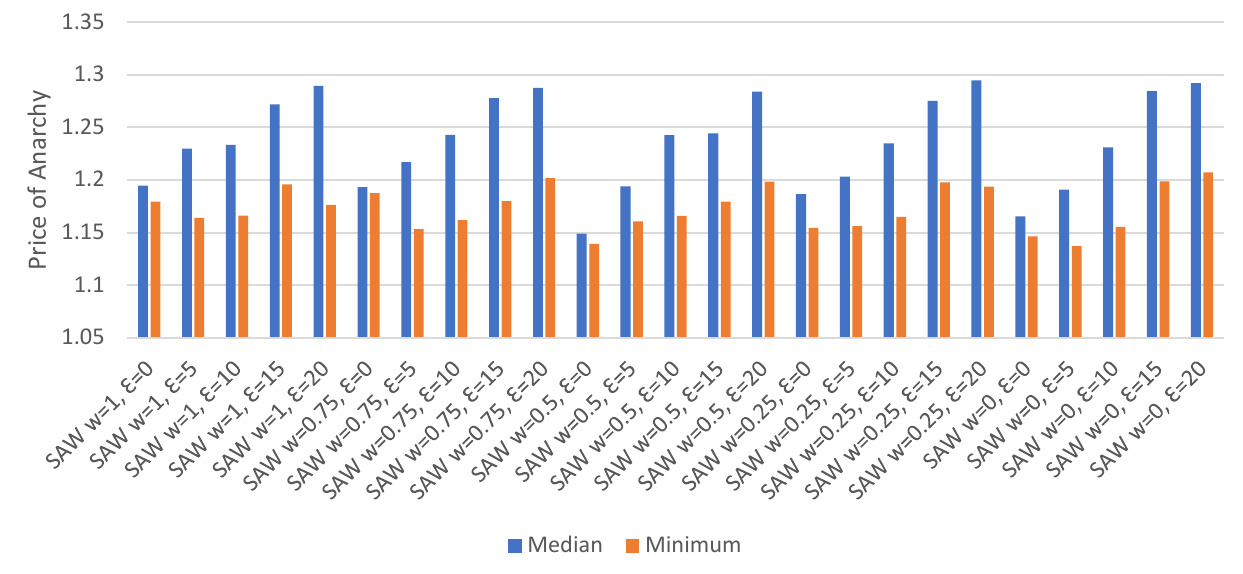
Figure 6. Minimum/median price of anarchy with direct experience, re-routing. User Equilibrium Points and Minimum Re-routes. Figure 7 displays the number of occurrences of user equilibrium and minimum re-routes for each set of parameters. Equilibrium occurred only where the epsilon value was set to 0, with the highest number of equilibrium points being 6 for w = 0.5. A comparison to direct experience with no re-routing indicates that the use of re-routing reduces the frequency of equilibrium. The minimum number of re-routes was found to be lowest where the SAW weight was 0 and epsilon was 0, while the trend across all sets of parameters showed that the minimum number of re-routes was highest with larger epsilon values. This is consistent with the equilibrium point data in that lower epsilon values tended to result in fewer poor route selections that would require correction through re-routing.